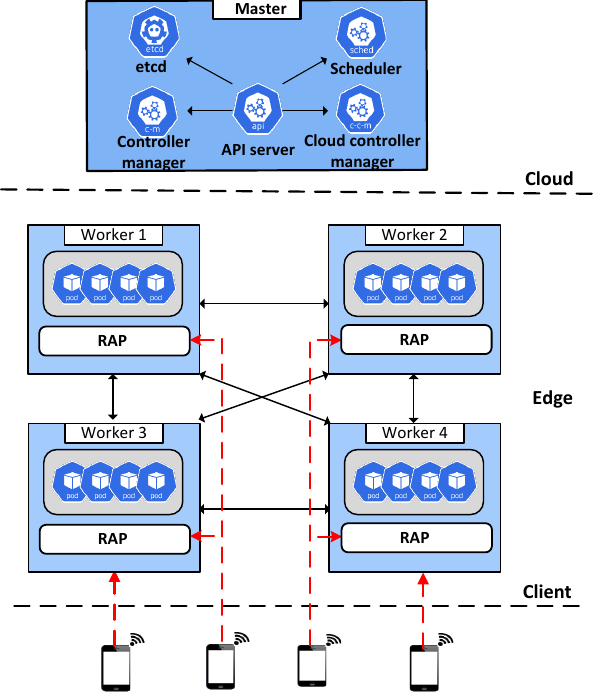
Figure 4. Architecture of RAP in an edge computing environment.